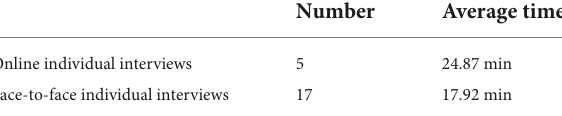
TABLE 1 Descriptive statistics of interview